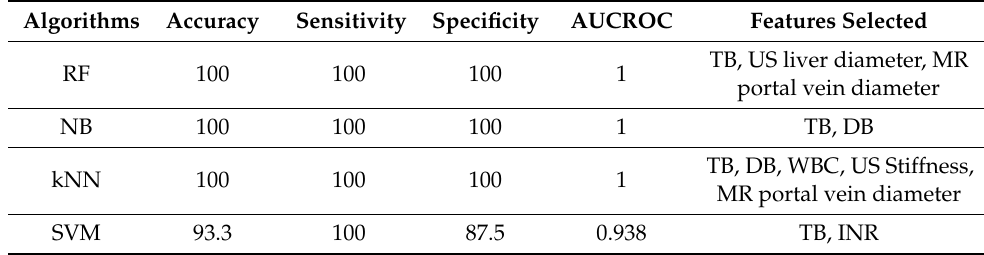
Table 7. Results using merged laboratory and imaging features after the SMOTE technique in predicting long-term medical